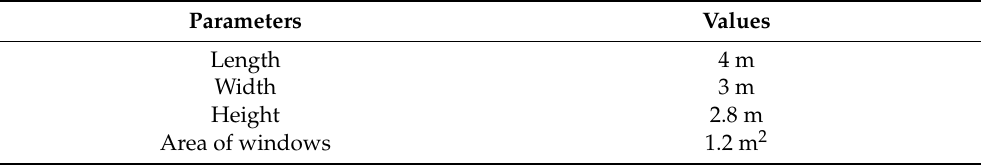
Table 1. Detailed parameters of simulated building.